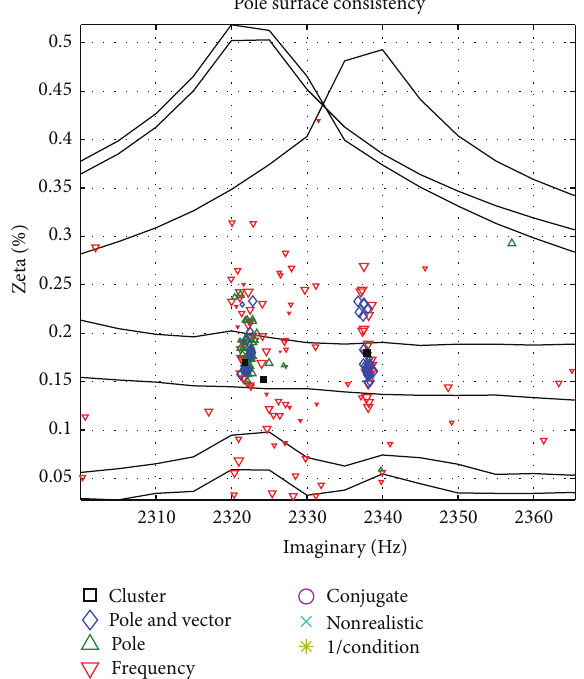
Figure 6: Pole surface consistency, 2320 Hertz